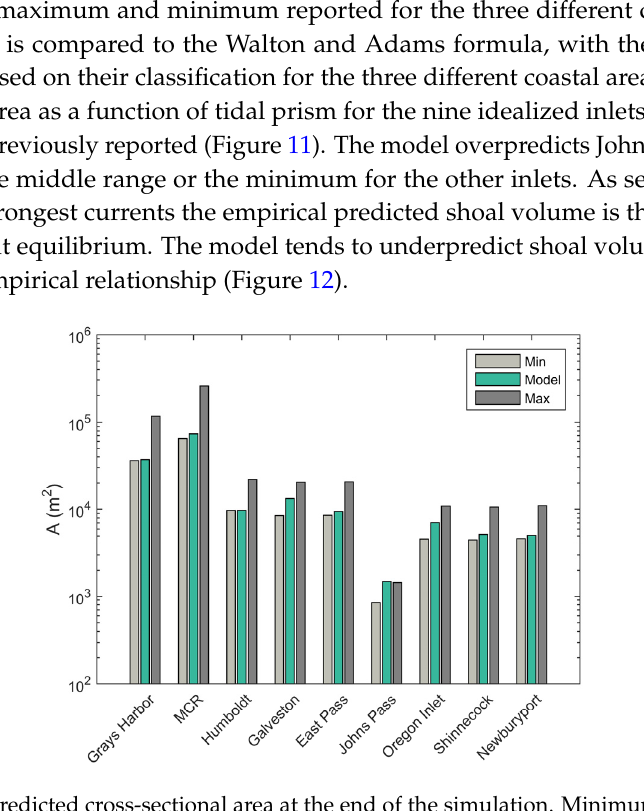
Figure 11. Model predicted cross-sectional area at the end of the simulation. Minimum and maximum denote the empirical tidal prism relationship [8] . J. Mar. Sci. Eng. 2016 , 4 , 65